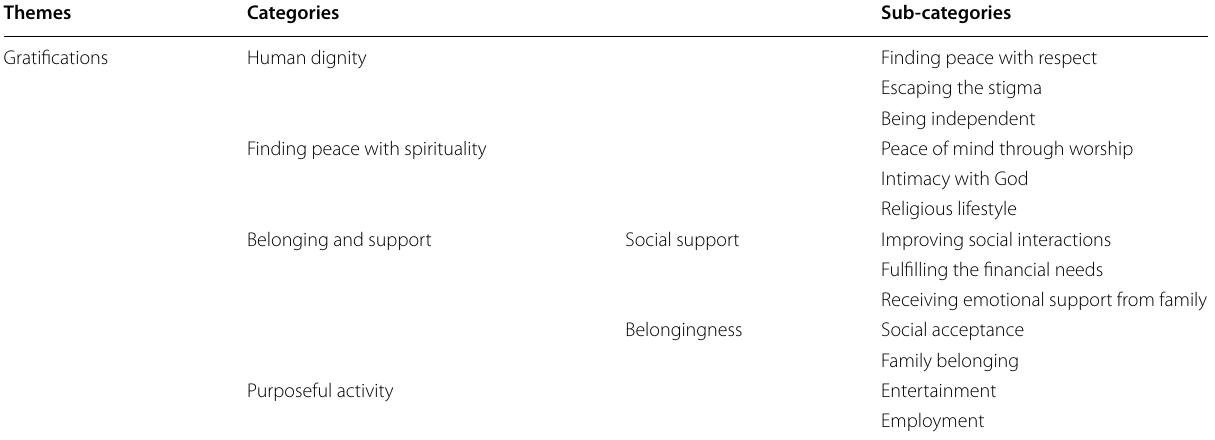
Table 5 Categories and themes extracted from in-depth